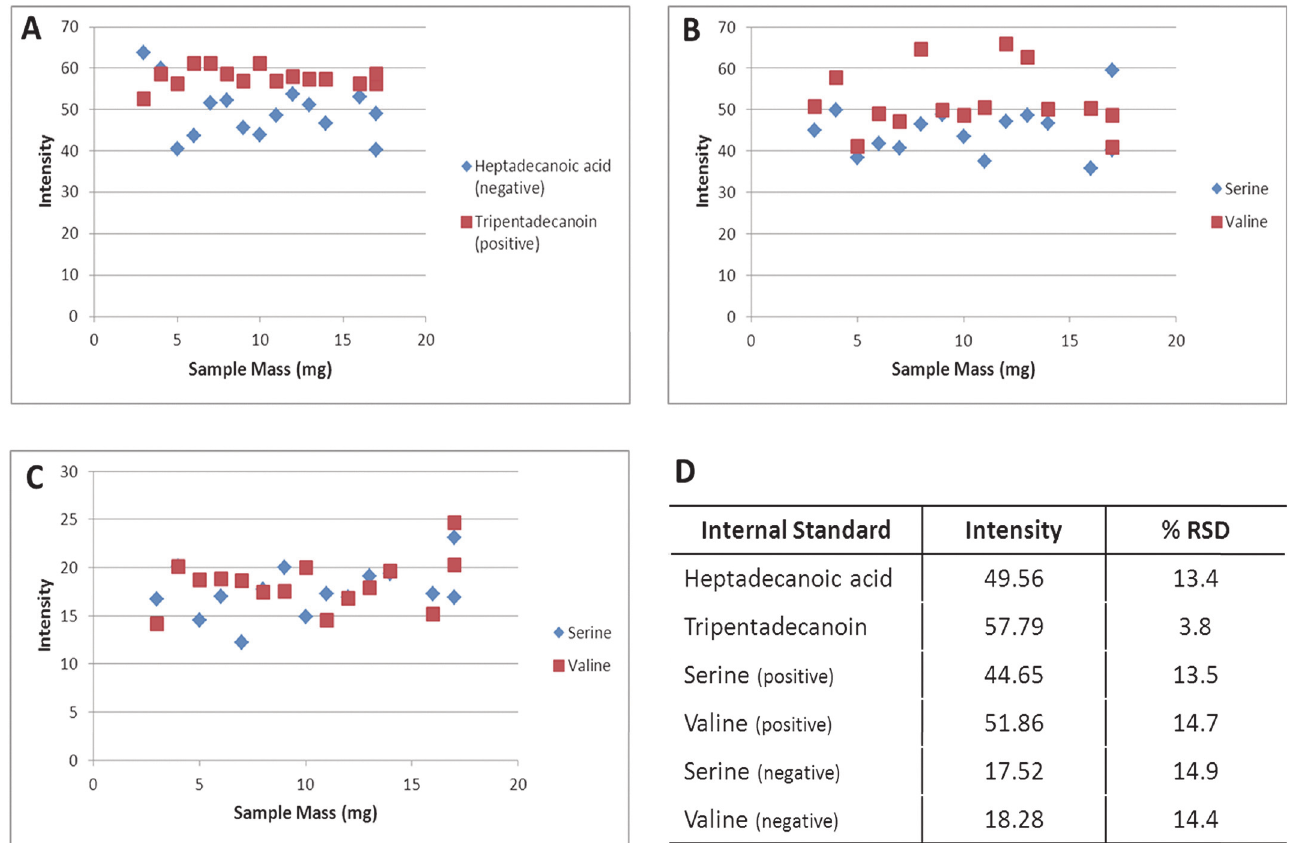
Fig 5. Recoveries of HILIC and reversed phase internal standards in experiment 2. A) plot of intensity of reversed phase internal standards Heptsdecanoic acid (negative) and Tripentadecanoin (positive), B) plot of intensity of HILIC internal standards in positive ionisation mode, C) plot of intensity of HILIC internal standards in negative ionisation mode, D) average intensity and coefficient of variance of all internal